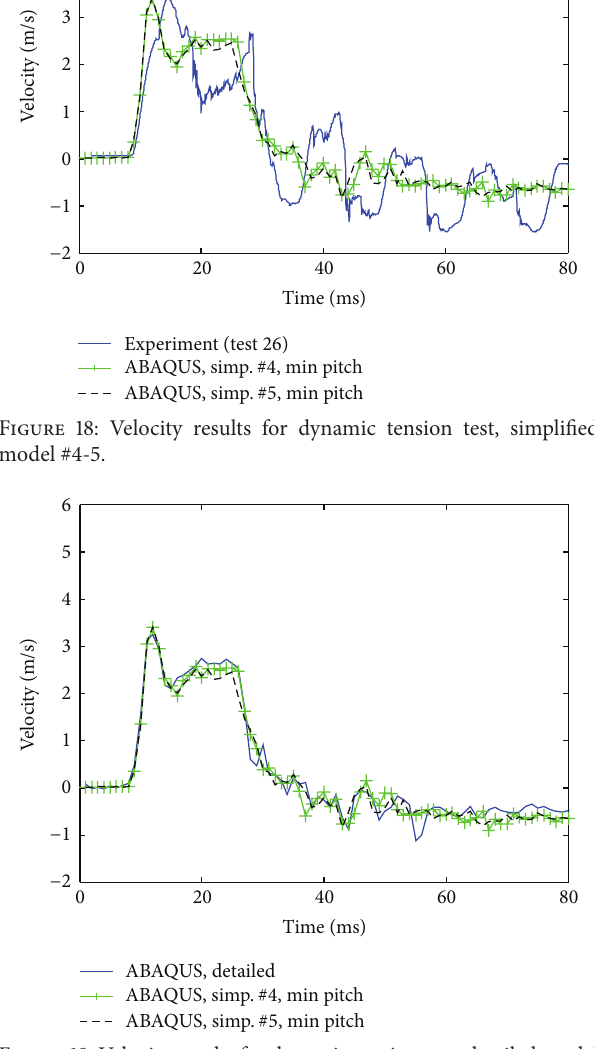
Figure 19: Velocity results for dynamic tension test, detailed model and simplified model